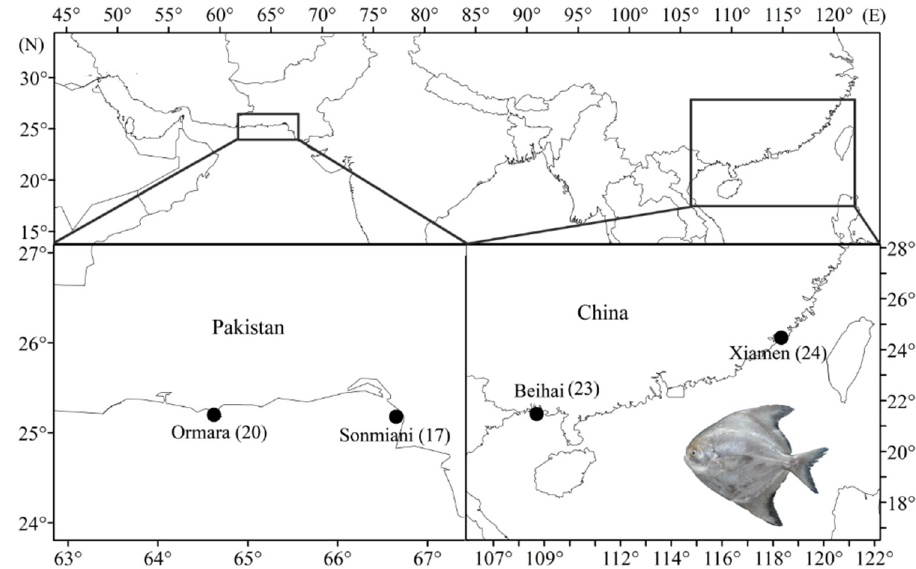
Fig. 1. Locations of populations used in this